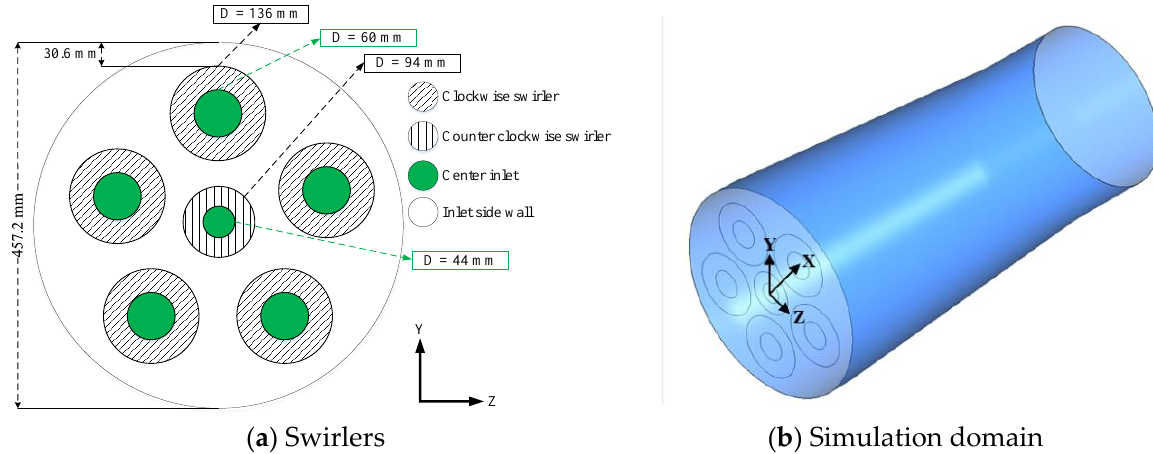
Figure 2. Simulation model of an inner combustor liner with six swirlers only for Model 1.